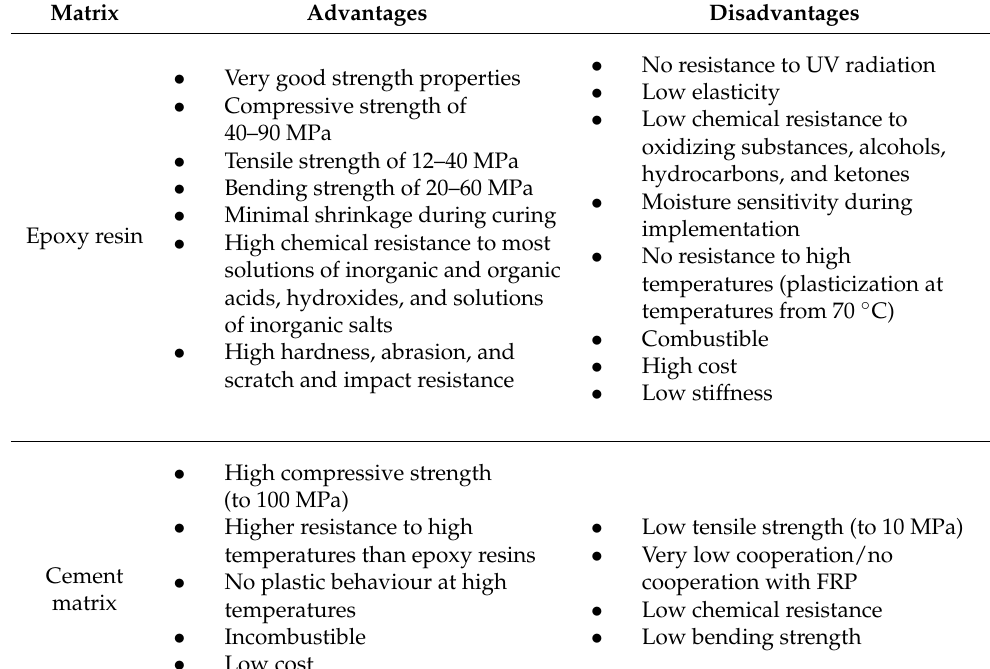
Table 4. Advantages and disadvantages of epoxy resin and cement matrix.